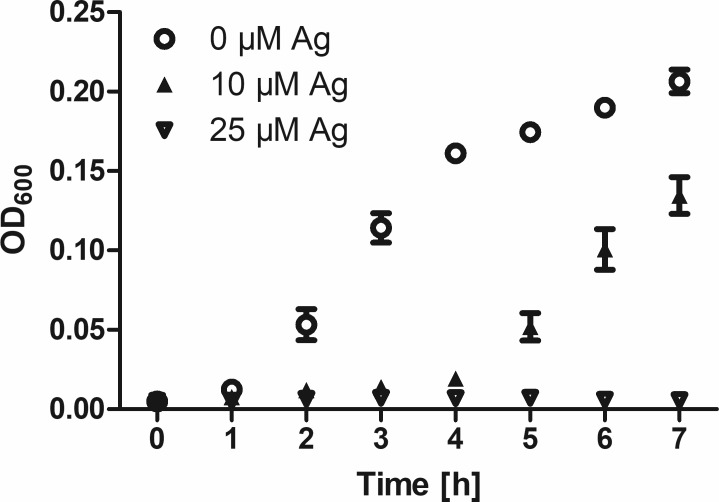
OD600 assay at different time points.Viability of E. coli cultured in the presence of the indicated concentrations of AgNO3. Data are shown as means +S.E.M. of n = 3 independent experiments.